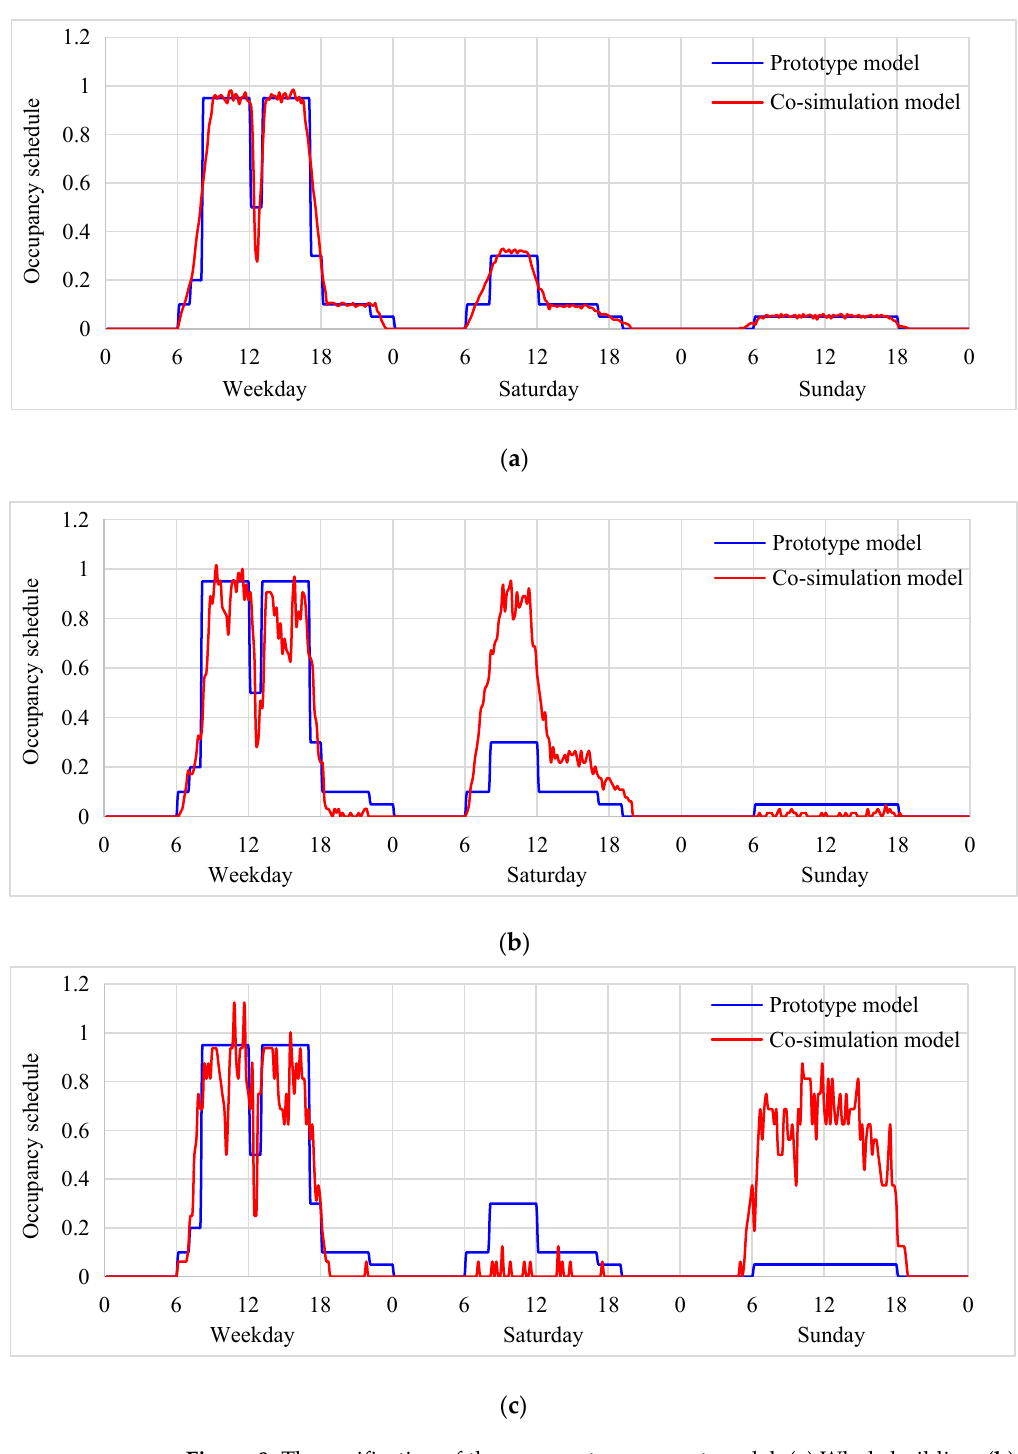
Figure 8. The verification of the occupant movement model: ( a ) Whole building; ( b ) F3C; ( c ) F1S.